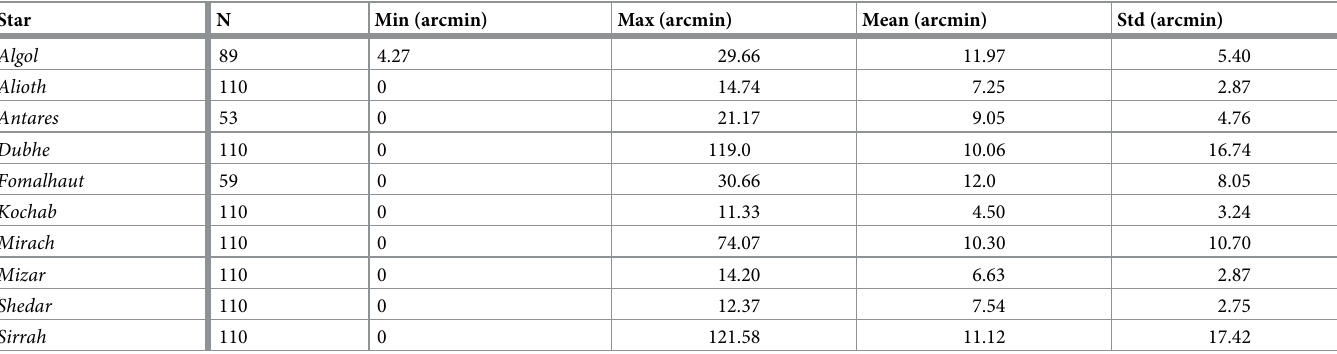
Table 1. Calibration check for others